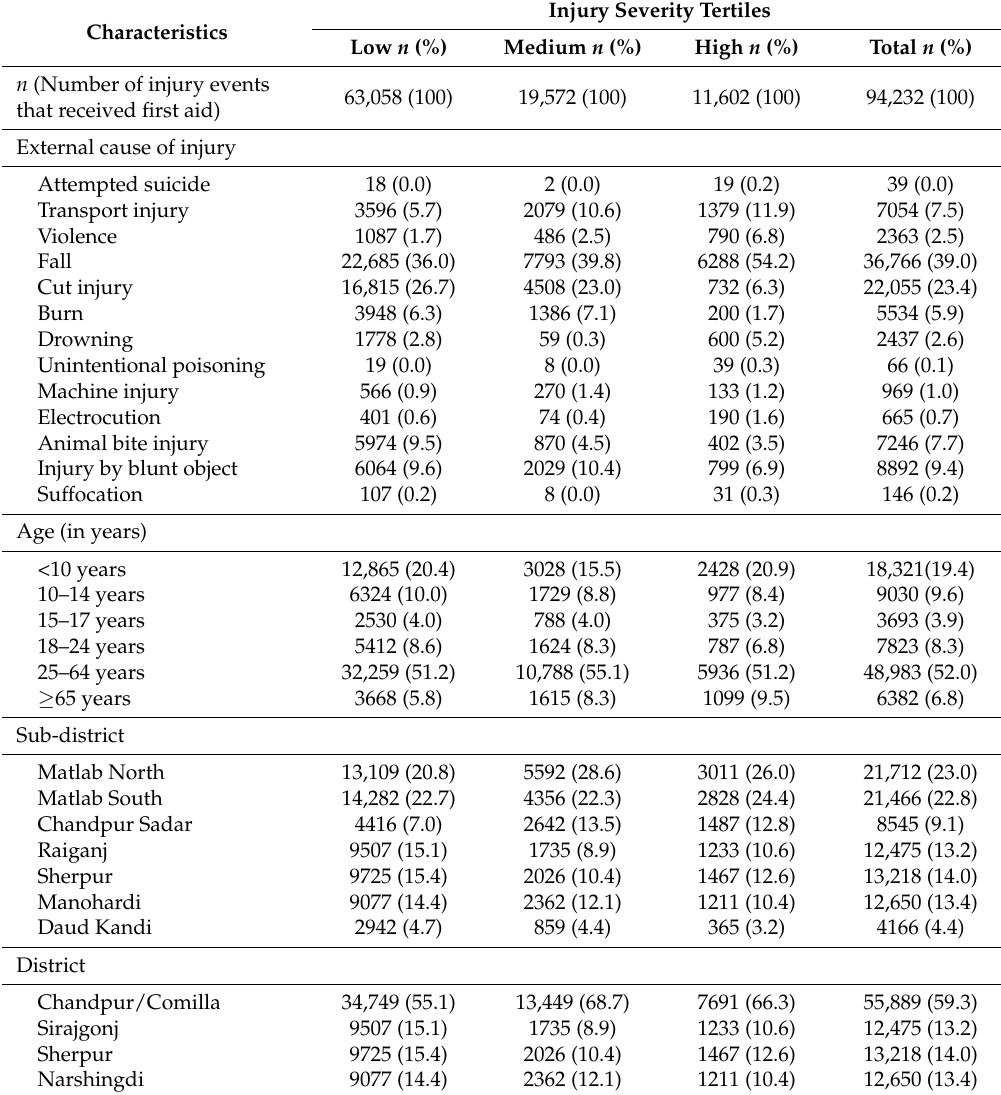
Table 4. The percentage of non-fatal injury events that received first aid by type of provider, injury mechanism, socio-demographic and geographical factors among different non-fatal injury severity